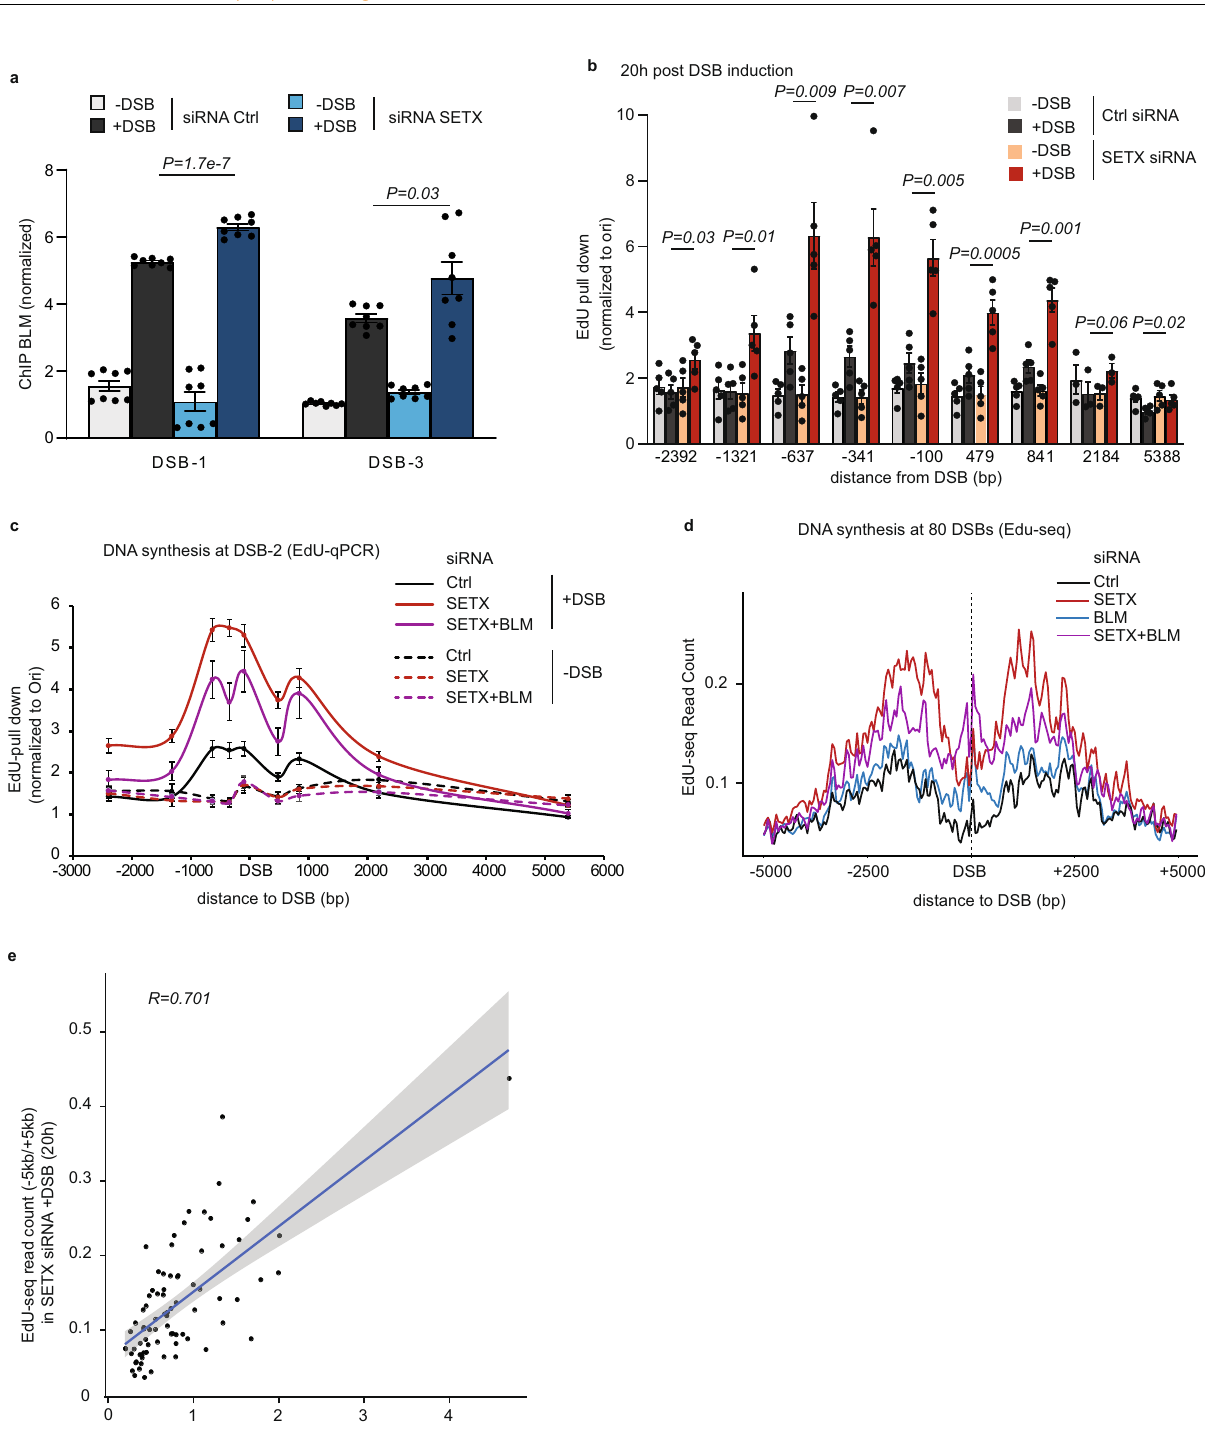
The toxicity of RNA:DNA hybrids at TC-DSBs is not linked to TAHRR de fi ciency but to POLD3/BLM-dependent DNA synthesis . SETX de fi ciency strongly impairs cell survival follow- ing DSBs in active loci 18 . Given that once damaged, transcribed loci accumulate RNA:DNA hybrids and that their dissolution is mandatory for RAD51 nucleo fi lament formation and proper execution of HR 14,18 , we previously postulated that HR de fi ciency may account for the observed decreased cell survival in SETX- de fi cient cells 18 . Here we found that inef fi cient RAD51 loading is not responsible for DSB-induced lethality upon impaired R-loop